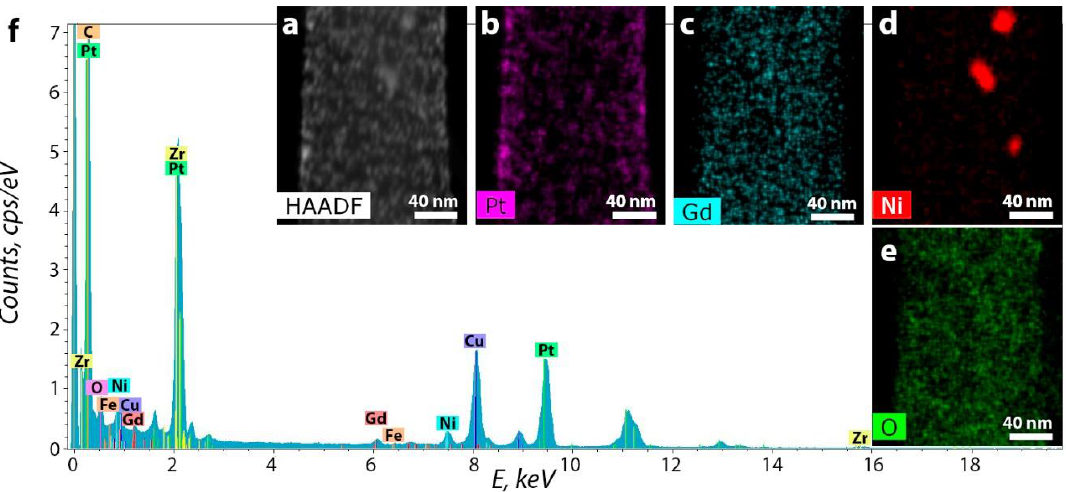
Figure 5. ( a ) HAADF STEM image; energy-dispersive X-ray spectroscopy (EDX) distribution maps for ( b ) platinum, ( c ) gadolinium, ( d ) nickel, ( e ) oxygen; ( f ) EDX spectrum for platinated pyrolyzed composite 1.